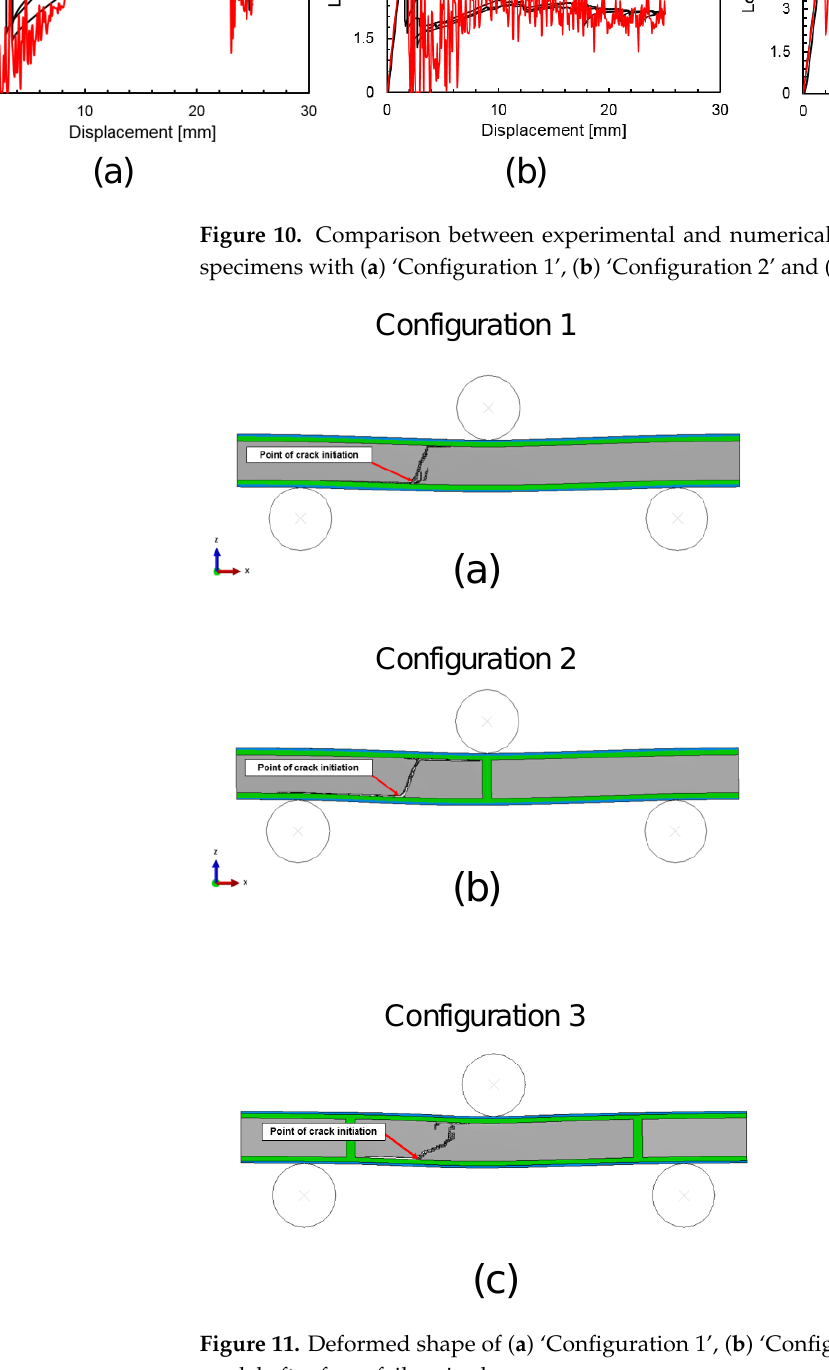
Figure 11. Deformed shape of ( a ) ‘Configuration 1’, ( b ) ‘Configuration 2’ and ( c ) ‘Configuration 3’ model after foam failure in shear.